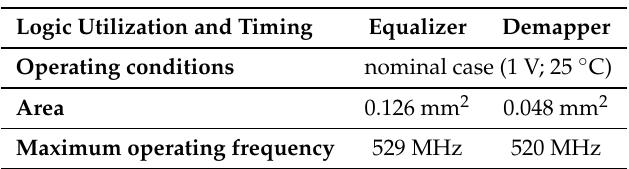
Table 2. Application-specific integrated circuit (ASIC) synthesis results of the proposed NISC-based equalizer and demapper architectures targeting 65-nm STCMOS technology.